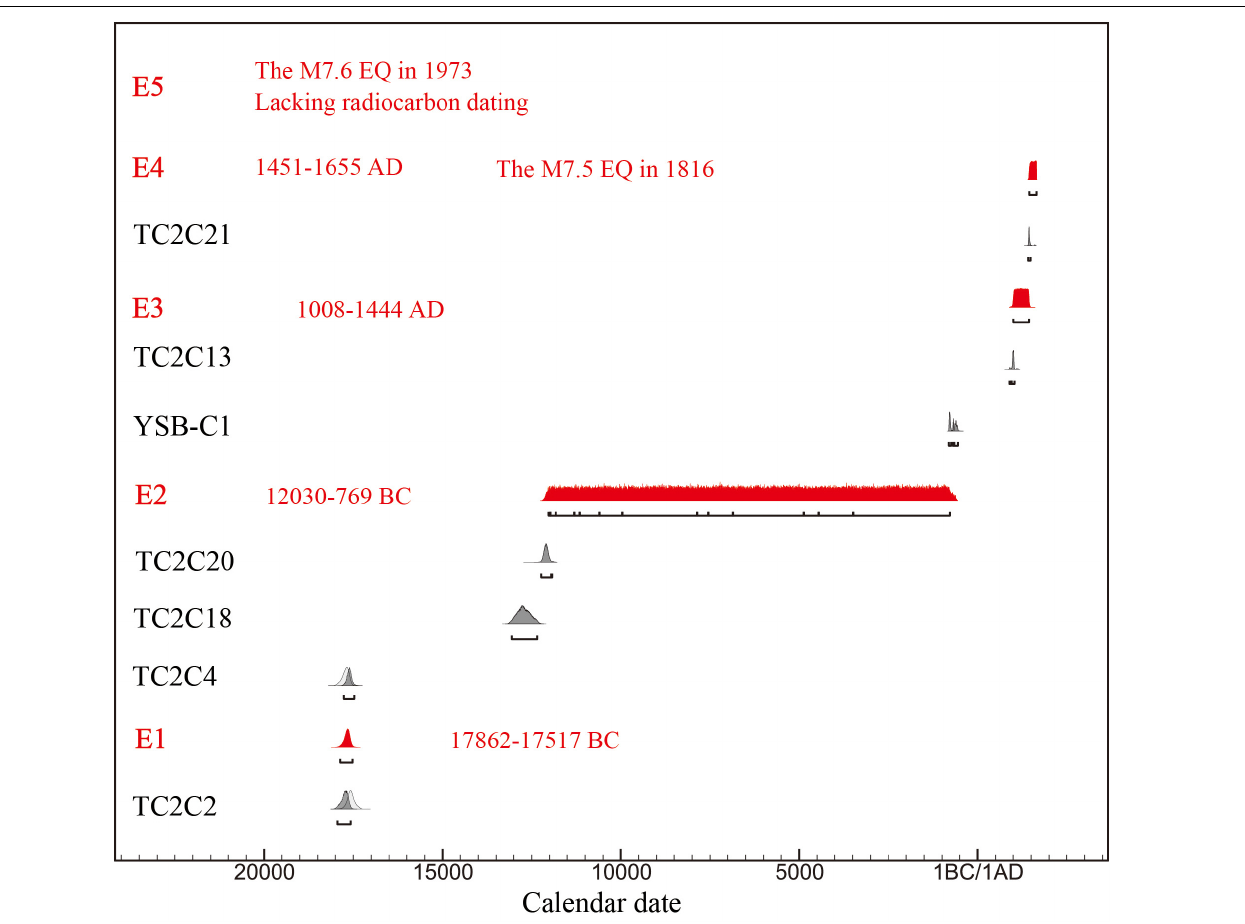
FIGURE 8 | Results of OxCal analysis of radiocarbon dates from site 1. The raw radiocarbon ages were calibrated using OxCal 4.3.1 (Ramsey and Lee, 2013).